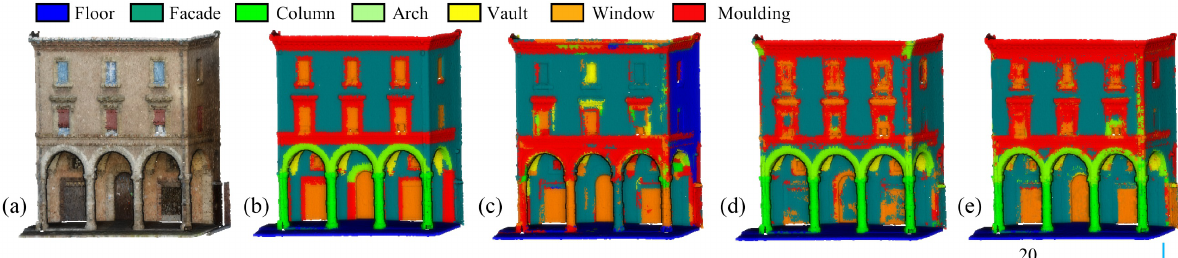
Figure 5. A portion of the Bologna dataset coloured (a) and hand-annotated (b), with its classification results achieved using clustering features (c), geometry-based features in a standard approach (d), combining clustering and geometry-based features